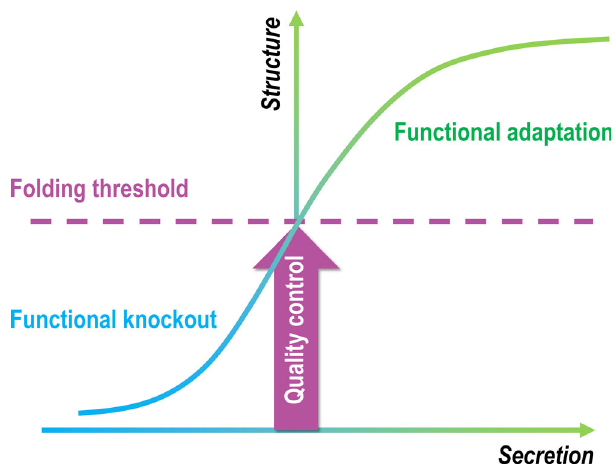
Fig. 6 The proposed folding threshold model of protein evolution. Functional constraints play a major role in shaping protein evolution, yet a folding threshold imposed by the eukaryotic quality control must be satis fi ed fi rst before functional selection can be effective for a large portion of secretory and luminal proteins. Therefore, mutations that disrupt the original fold without giving rise to an alternative stable fold are equivalent to functional knockout. Only those that meet the threshold will be selected further leading to functional improvement and/or